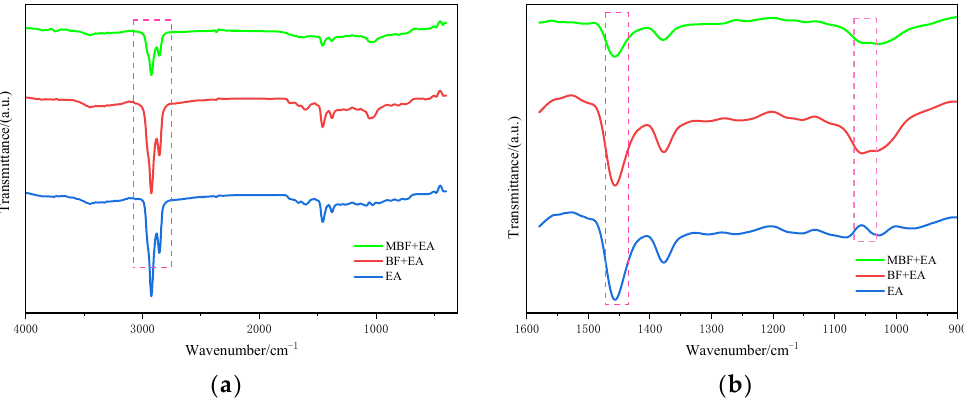
Figure 17. Infrared spectrum of fiber-emulsified asphalt before and after modification: ( a ) full band; ( b ) 900 cm − 1 –1600 cm − 1.